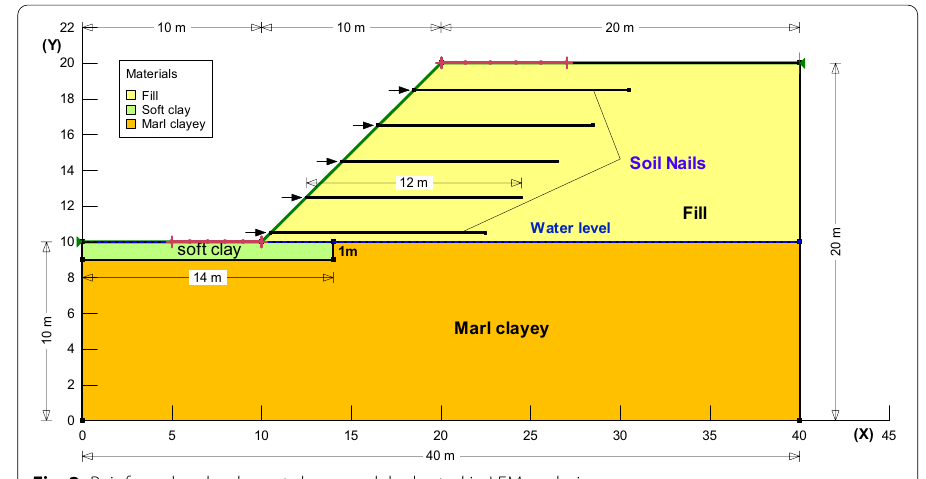
Fig. 2 Reinforced embankment slope model adopted in LEM analysis